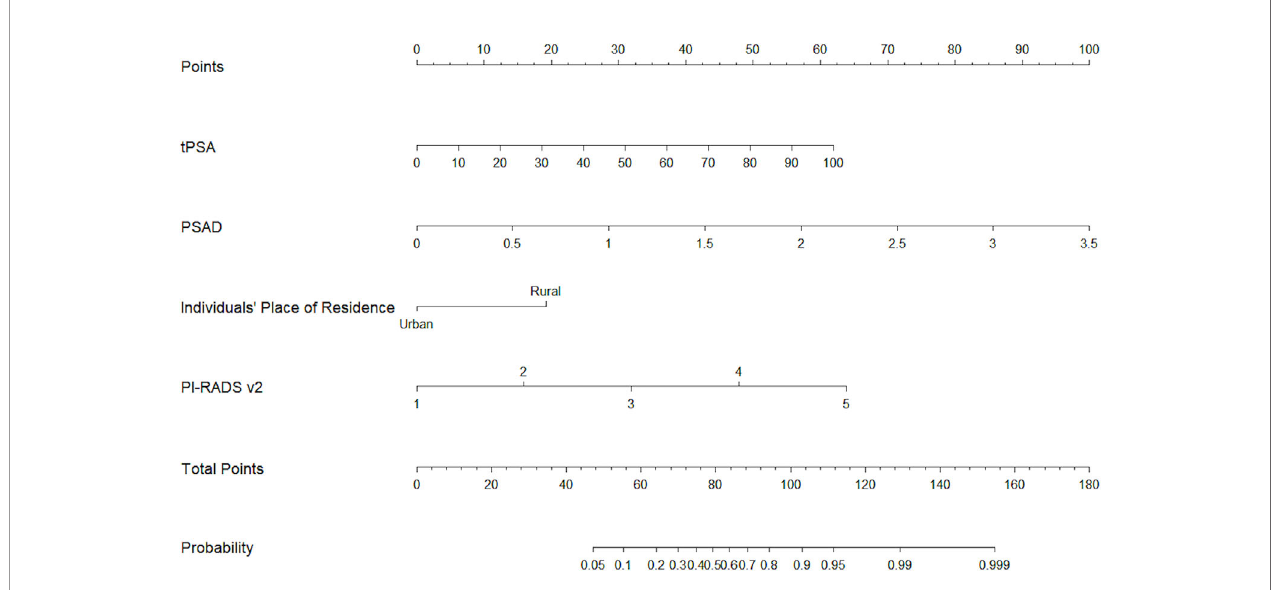
FIGURE 3 | The nomogram for predicting prostate biopsy results for high-grade PCa.